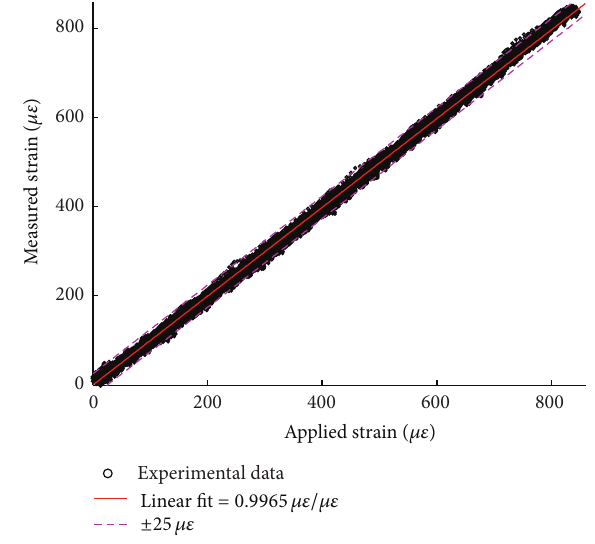
Figure 3: Measured (from SEC) versus applied (from foil gauge)